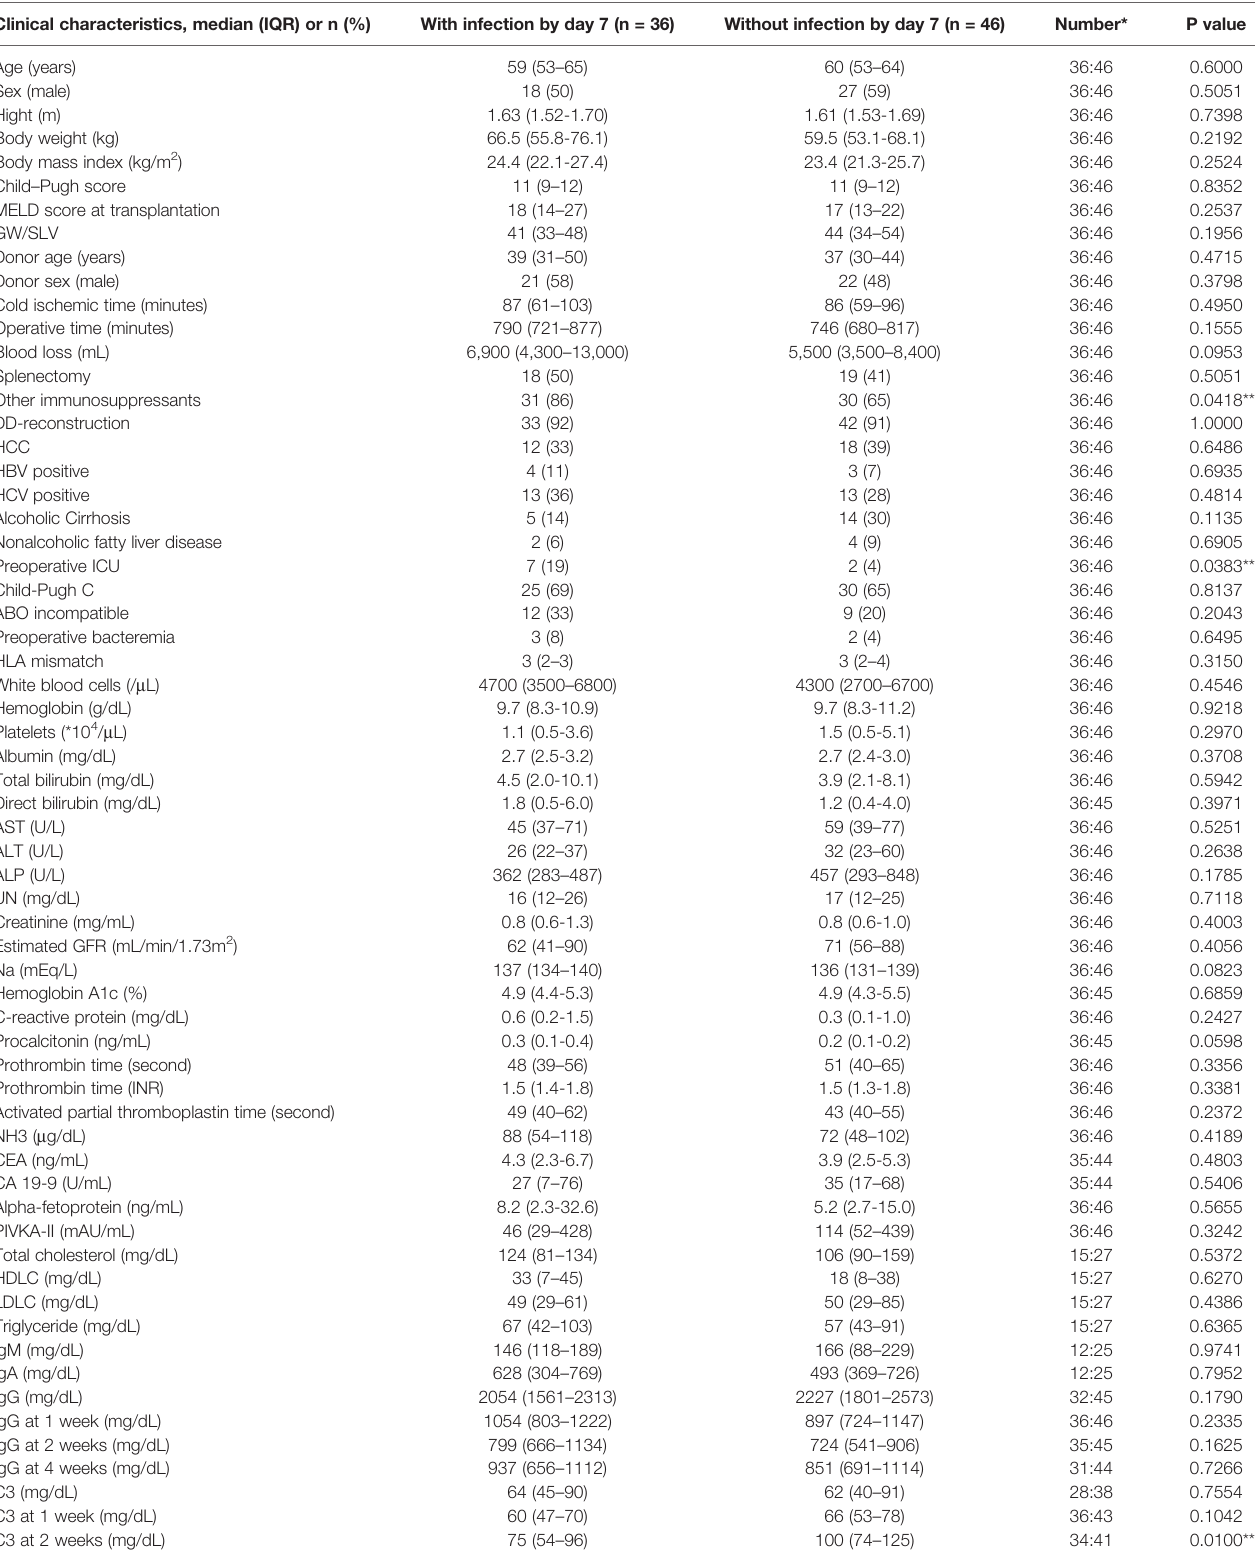
TABLE 2 | Clinical characteristics of patients with or without infection by day 7. Clinical characteristics, median (IQR) or n (%) With infection by day 7 (n = 36) Without infection by day 7 (n = 46) Number* P value Age